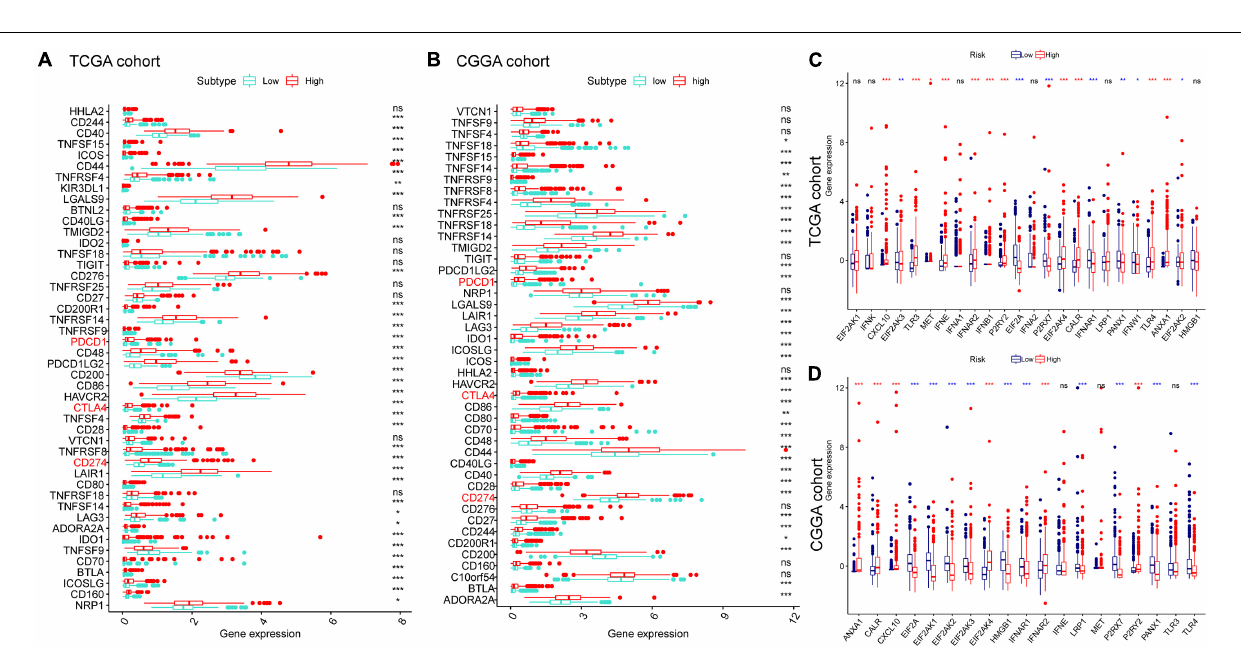
FIGURE 7 | Association between risk subtypes and ICPs and ICD modulators. Differential expression of ICP genes among the risk subtypes in (A) TCGA and (B) CGGA cohorts. Differential expression of ICD modulator genes among the risk subtypes in (C) TCGA and (D) CGGA cohorts. * p < 0.01, ** p < 0.001, and *** p <